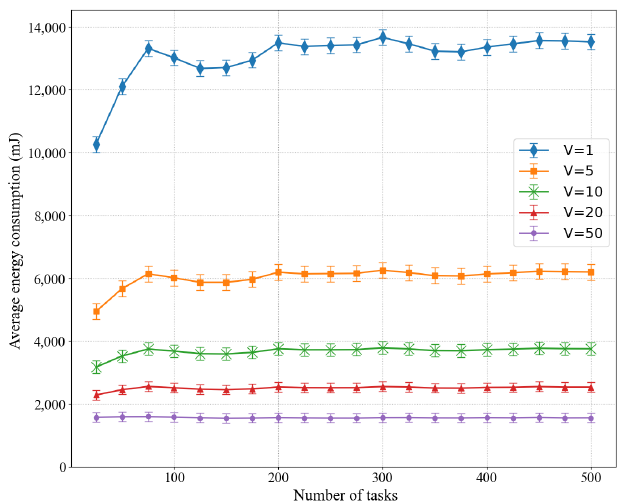
Figure 3. Influence of different values of weight V on average energy consumption.